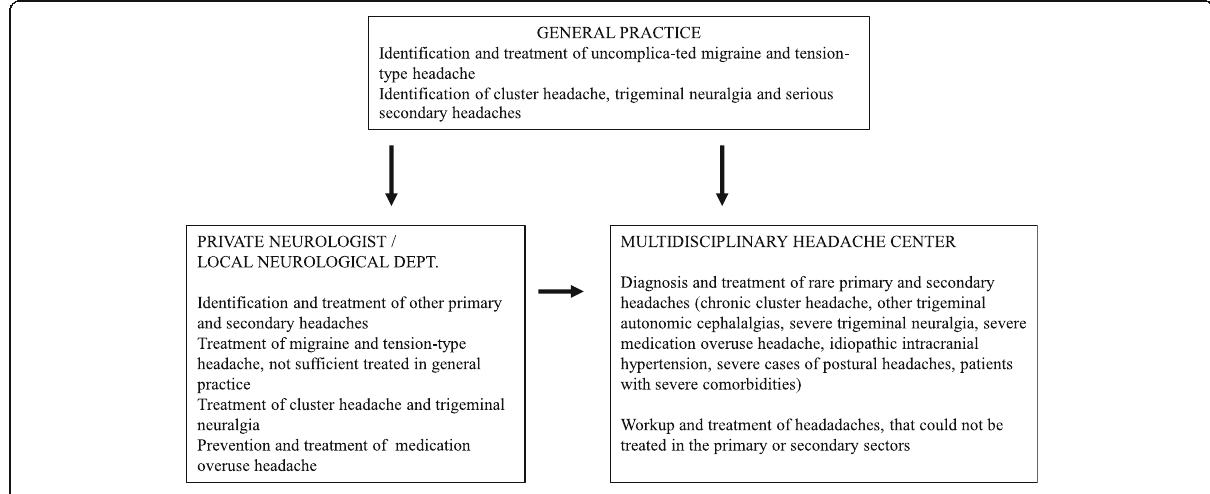
Fig. 3 Organisation of treatment in